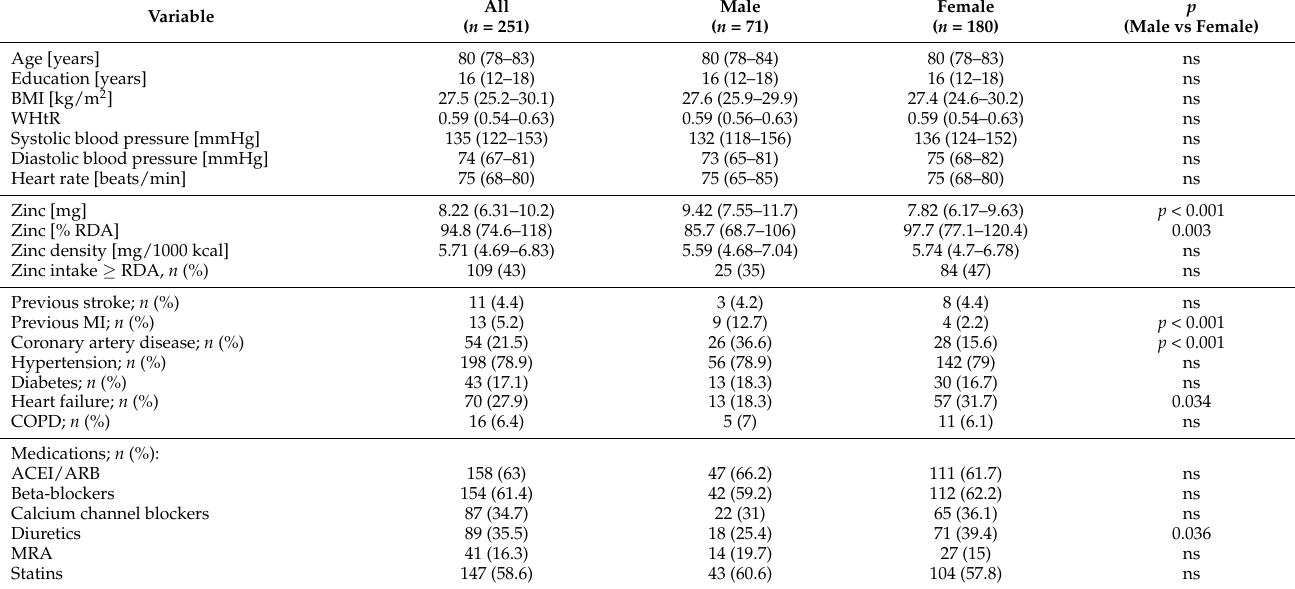
Table 1. General characteristics of the study population according to sex. The quantitative values are expressed by median, lower and upper quartile or mean and standard deviation, qualitative values as number and